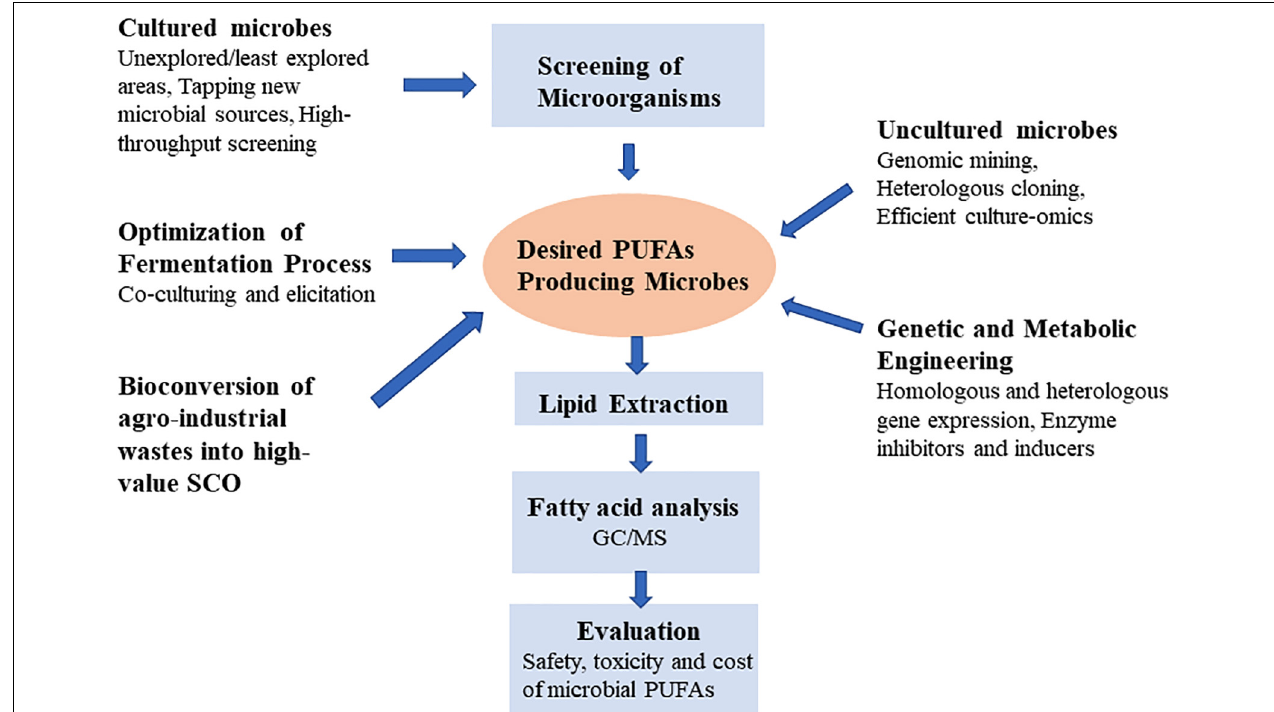
FIGURE 2 | Strategies for ensuring the discovery of novel microbial PUFA